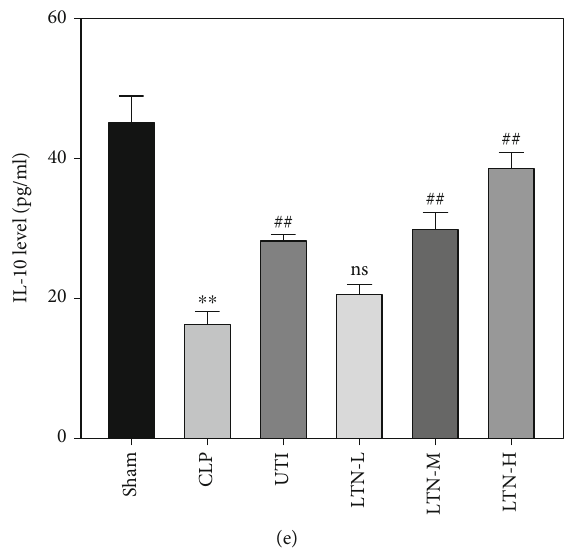
Figure 2: Lentinan reduces the in fl ammatory response caused by gut-origin sepsis. The contents of proin fl ammatory cytokines TNF- α (a), IL-6 (b), IL-1 β (c), and HMGB1 (d) and anti-in fl ammatory cytokine IL-10 (e) in serum of mice were detected by ELISA. The experimental results were expressed in the form of the mean ± standarddeviation (SD). ∗∗ p < 0 : 01 vs. sham group; # p < 0 : 05 and ## p < 0 : 01 vs. CLP group. ns: no statistical signi fi